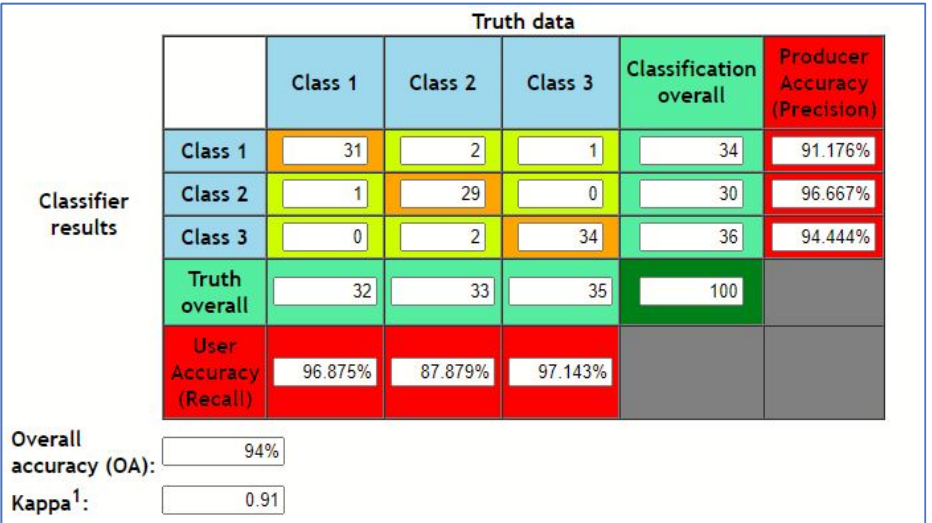
Figure 5. DT Performance. The accuracy of Decision Tree is 94% as shown in the truth table (Fig- ure 5).